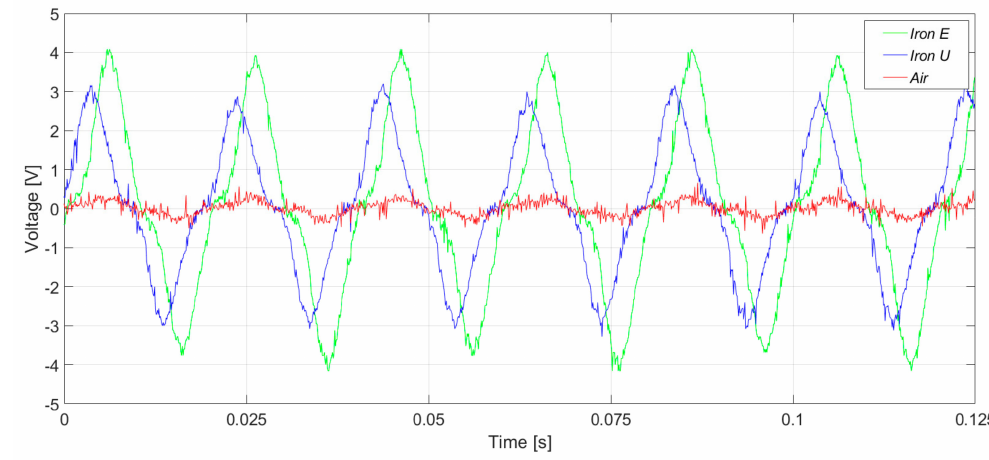
Figure 17. Induced voltage measurement with a 4% inter-turn stator fault severity.